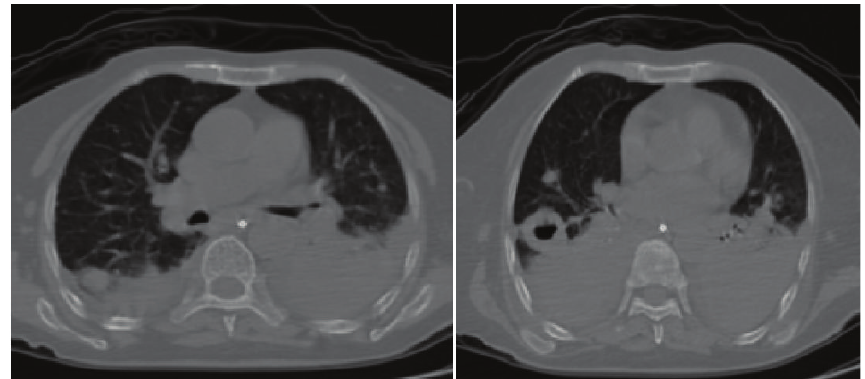
Figure 7: Parenchymal window of computed tomography scan showing bilateral pleural masses, effusions, and enlarged cavitary lesion at the time of respiratory